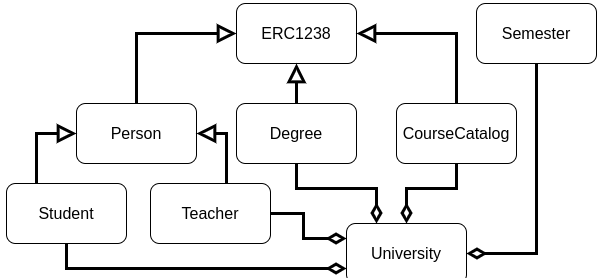
Figure 3. The class diagram of the PoC application.